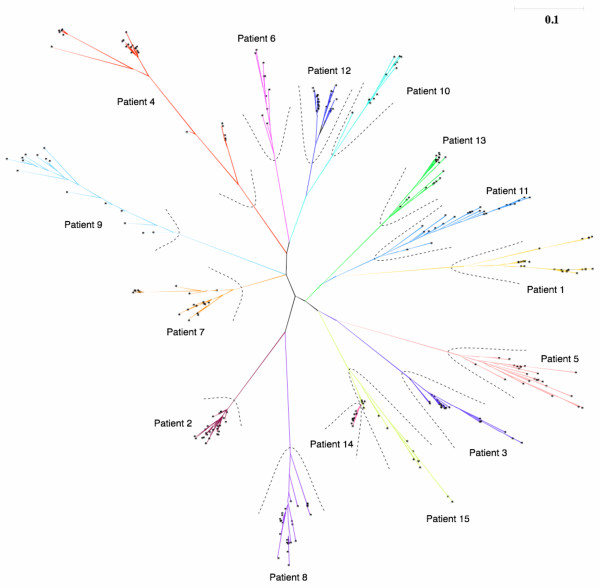
Phylogenetic tree analysis showing patient sequence purity. Phylogenetic analysis on the 305 HIV-1 env gp120 C2-V5 region sequences from plasma, peripheral blood mononuclear cells, CD4+ T cells, CD8+ T cells and monocytes. Using the ProML program of the PHYLIP software package, a maximum likelihood phylogenetic tree was calculated for our patient sequences. The branch lengths are scaled to distance. A single asterisk represents each sequence from our dataset. Individual sequences are not identified as it is only the broad pattern of clustering that is of interest here. Distinct clustering of patient-related sequences can be seen from the phylogenetic tree.